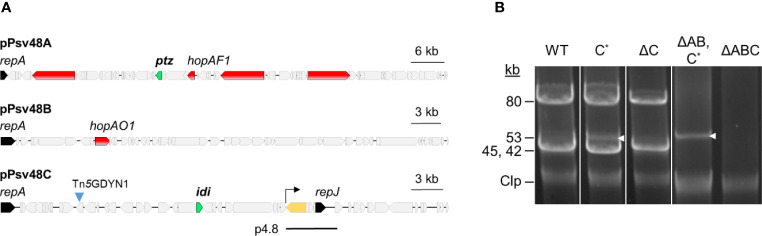
Plasmid profiles of plasmid-cured derivatives of Pseudomonas
syringae pv. savastanoi NCPPB 3335. (A) Map of the three virulence plasmids of Ps pv. savastanoi NCPPB 3335, showing in red, two type III effector genes (hopAF1 and hopAO1) and three putative virulence genes; in green, genes coding for cytokinin biosynthesis enzymes; in black, genes for replication initiator proteins; and in yellow, the only copy of IS801 in pPsv48C, with the arrow indicating the direction of one-ended transpositions. The black line labeled as p4.8 indicates the position and extent of the deleted derivative of pPsv48C present in strain ΔC. (B) Uncut plasmids were separated by electrophoresis in agarose gels from the strains shown. Strains: WT, wild type NCPPB 3335; letters after the Δ symbol indicate the plasmid(s) missing in each strain; C*, pPsv48C::Tn5-GDYN1, indicated by white arrowheads. Clp, chromosome and linearized plasmids.